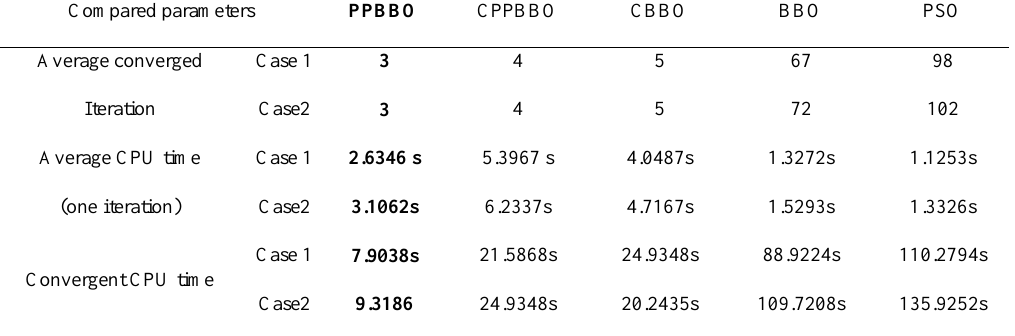
Table 1. Comparative results by five different algorithms Compared